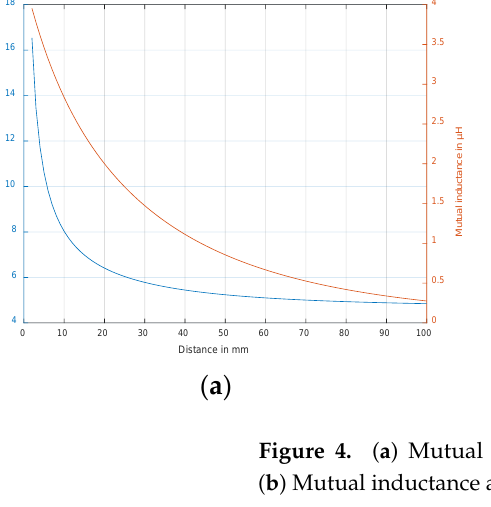
With the calculated mutual inductance, the frequency of the resonant circuit can be expressed as a function of the distance h . For this purpose, the inductance and capacitance of the resonant circuit without plate were measured ( L = 4.3 µ H, C = 260 nF). Figure 4a shows the resulting mutual inductance and frequency of the resonant circuit over the distance h of 2–100 mm and Figure 4b shows the according change in mutual inductance and frequency over 2–3 mm. Therefore, we can assume a nearly linear dependency for small distance changes.